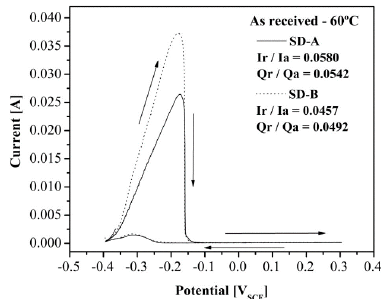
Figure 3. I + 0.01 M KSCN + 0.50 M NaCl solution test at room temperature.